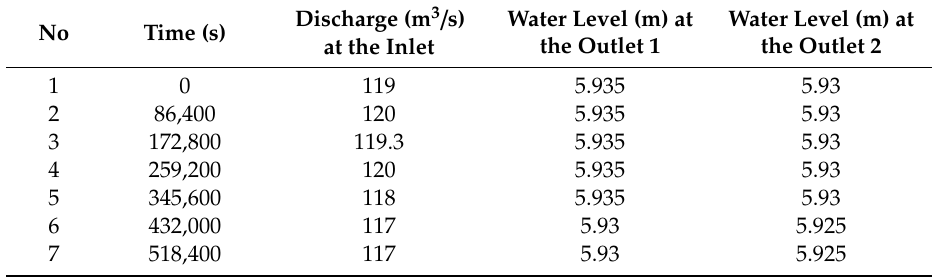
Table 4. Discharge and water level of the Tigris branching channel used for model